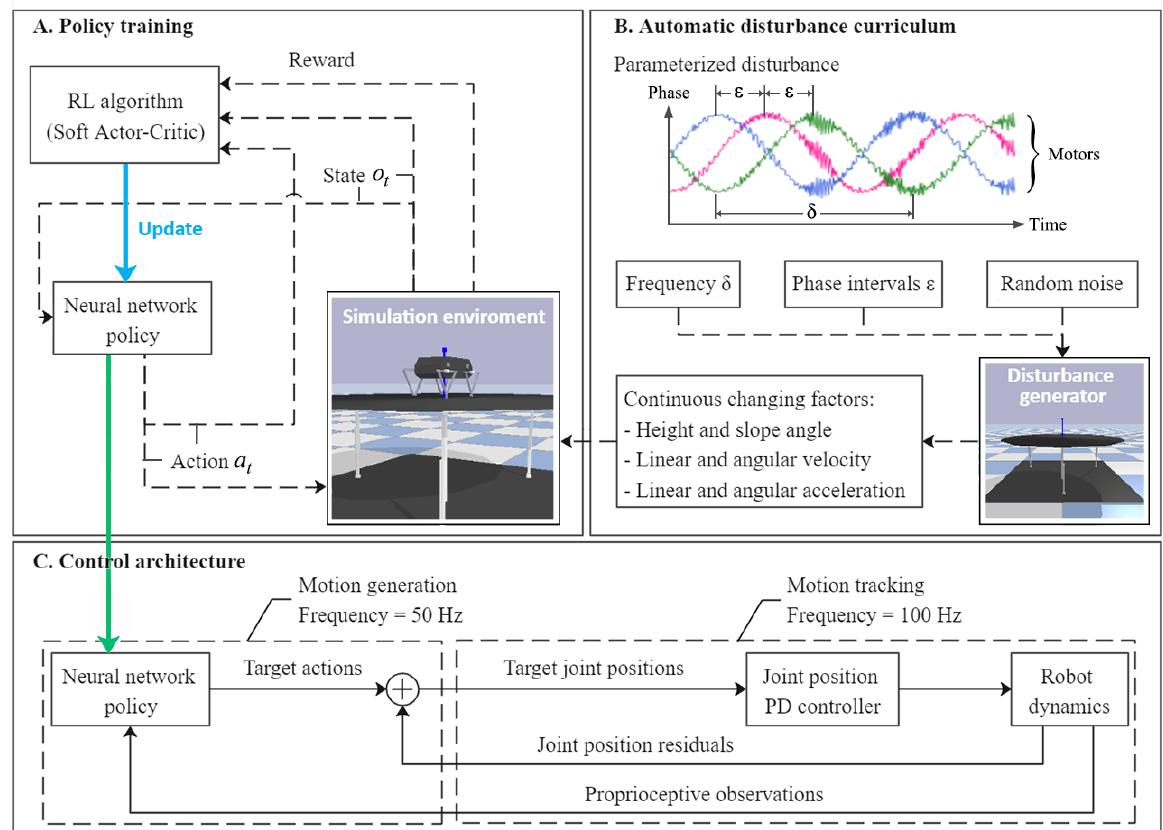
Figure 1. Overview of training and control architecture.